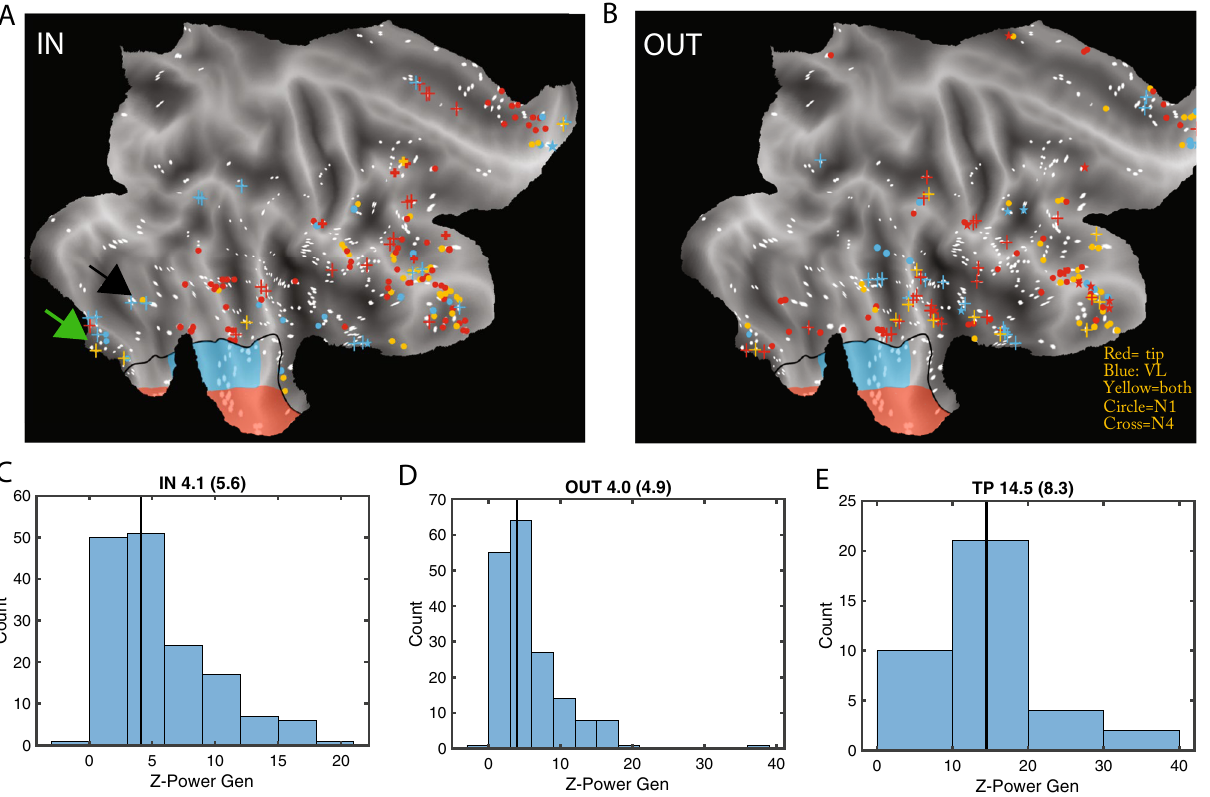
Figure 6. Properties of outside leads connected to T and VL: ( A ), ( B ) flatmaps of right hemisphere showing outside leads providing input to VL (blue), T (red) or both ( yellow) at short (dots) and long (crosses) delays (A), or receiving output from VL (blue), T (red) or both (yellow) at short (dots) or long (crosses) delays (B); white dots: unconnected leads; black full line border of TP with VL in blue and T in red. Black and green arrows point to FFA (black) and LG1 (green) in ventrolateral temporal cortex. ( C ), ( D ), ( E ) distribution of responses in gender task of leads providing input to Tip and VL regions of TP ( C ), receiving from T and VL ( D ) and within T and VL ( E ) with indication of the median (value in title, with interquartile range in parenthesis), which is almost three times larger in TP than